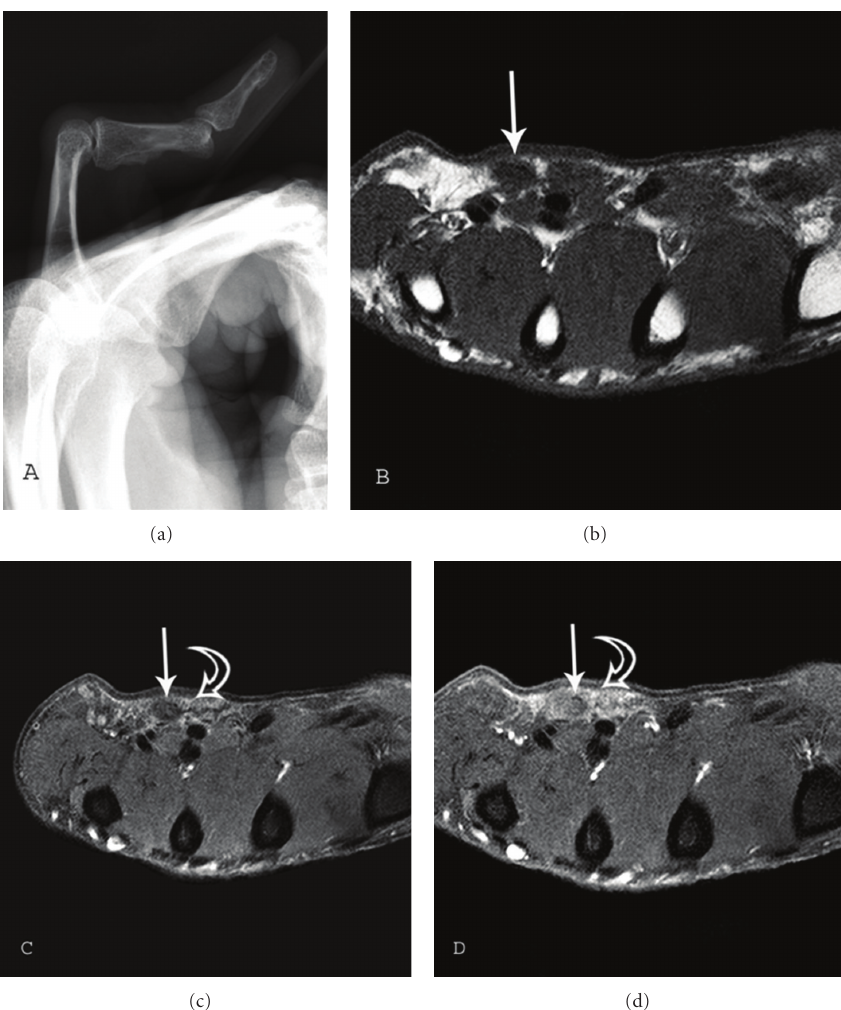
Figure 1: Palmar Fibromatosis. Lateral radiograph (a) of the right hand 5th finger in a 48-year-old man shows a flexion (Dupuytren) contracture of the proximal interphalangeal (PIP) joint. MR images of a 73-year-old man with pathologically proven palmar fibromatosis. (b) Axial T1-weighted (TR 500/TE 21) and (c) axial proton-density-weighted (TR 1500/TE 35) fat suppressed images of the hand at the level of the metacarpal bones show nodular areas of low-signal intensity in the volar subcutaneous fat (arrows) located superficial to the flexor tendons of the fourth and fifth fingers. Increased signal surrounds the nodules (curved arrow) on fluid sensitive sequence. (d) Axial T1-weighted (TR 500/TE 21) fat-suppressed image after administration of gadolinium contrast demonstrates moderate and di ff use enhancement (curved arrow) surrounding the